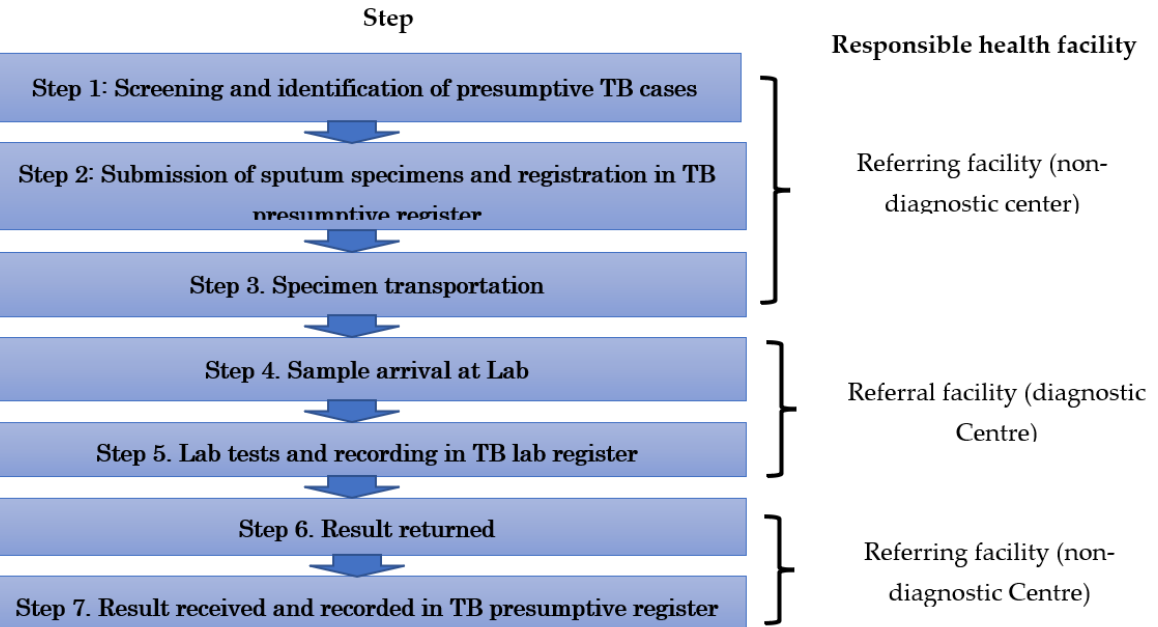
Figure 1. Steps in an ideal sputum specimen referral cascade.